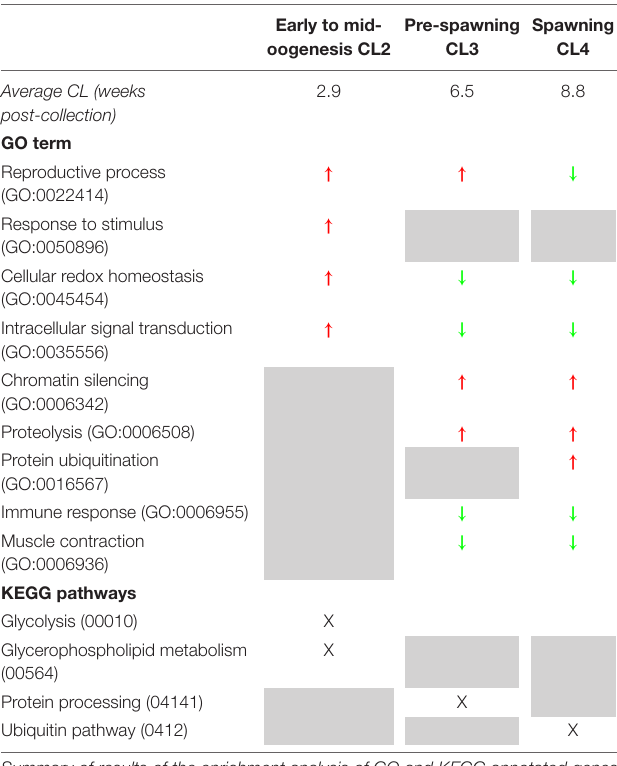
Summary of results of the enrichment analysis of GO and KEGG annotated genes that had been identified as DEGs in pairwise comparisons between “diapause” (CL1) and “early to mid-oogenesis” (CL2), “pre-spawning” (CL3) and “spawning” (CL4) clusters. Average time post-collection (weeks) of females within a cluster is indicated. Enriched GO terms within the Biological Process category and their GO number are listed. Direction of differential expression is indicated by the colored arrows: red up-arrows show processes that are up-regulated in females in the cluster of that column compared with ‘diapause’ (CL1) females. Green down- arrows show enriched processes that are down-regulated in cluster listed for the column compared with “diapause” (CL1) females. List of enriched KEGG pathways and their identifiers (in parenthesis) are marked by an ‘X’. Empty squares indicate that the process or pathway was not over-represented among the DEGs in the specific